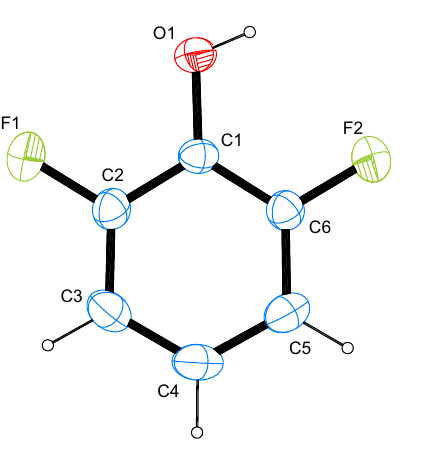
Table  : Fractional atomic coordinates and isotropic or equivalent isotropic displacement parameters (Å 